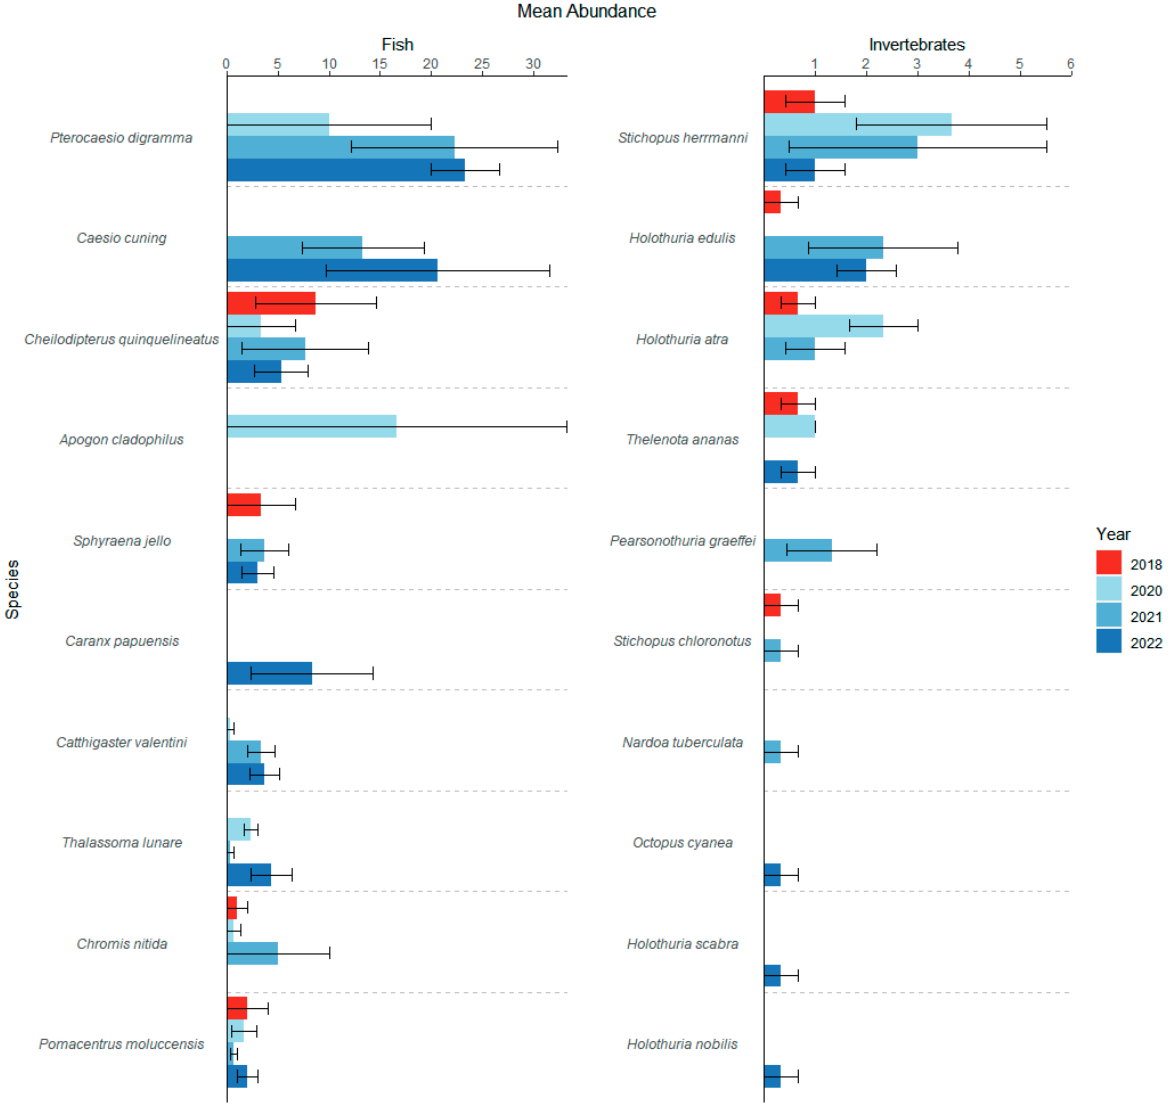
Figure 8. Mean abundance across three transects of fish ( left ) and macroinvertebrate ( right ) species ordered by species with highest representation across 2018–22. The 10 species with the greatest representation are displayed.